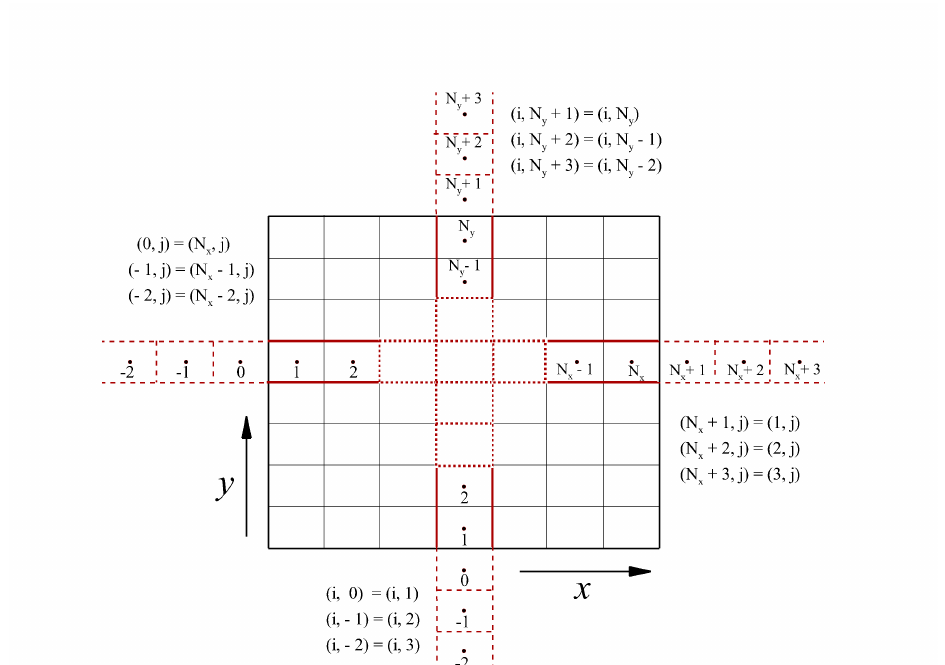
Figure 2. Illustration of the periodic boundary condition (left and right boundaries) and the reflective boundary condition (top and bottom boundaries) on an arbitrary two-dimensional